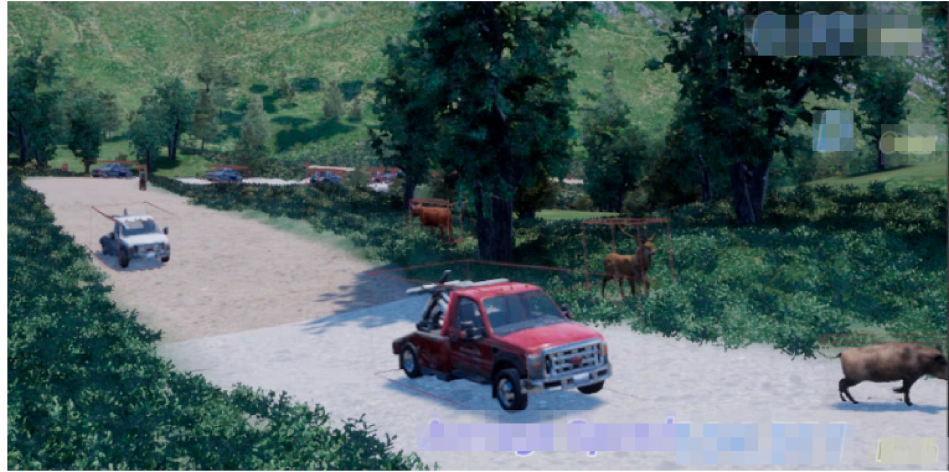
Figure 10. Mountain scenario result of normal mode.